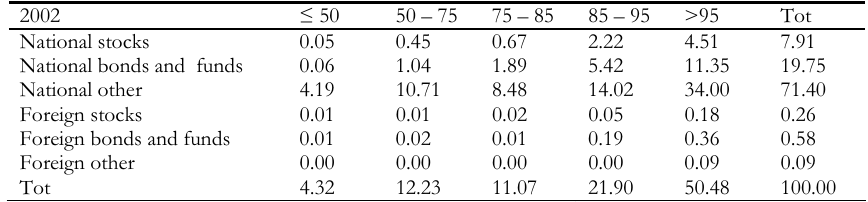
Italian households financial wealth by total financial assets percentiles, 2002 , percentages